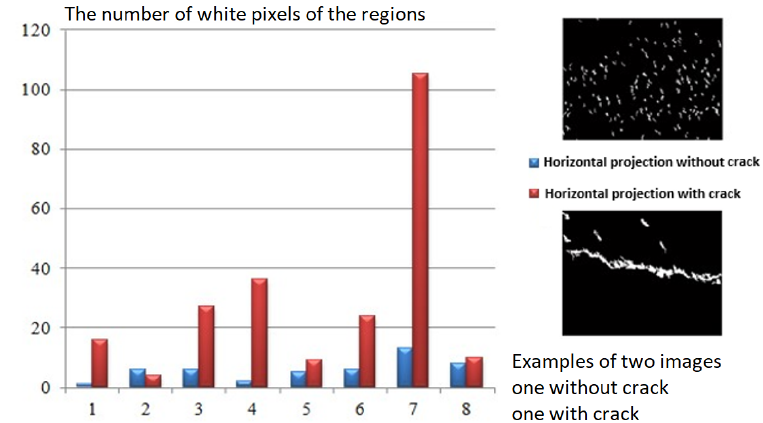
Figure 8. Determination of horizontal projection peaks.